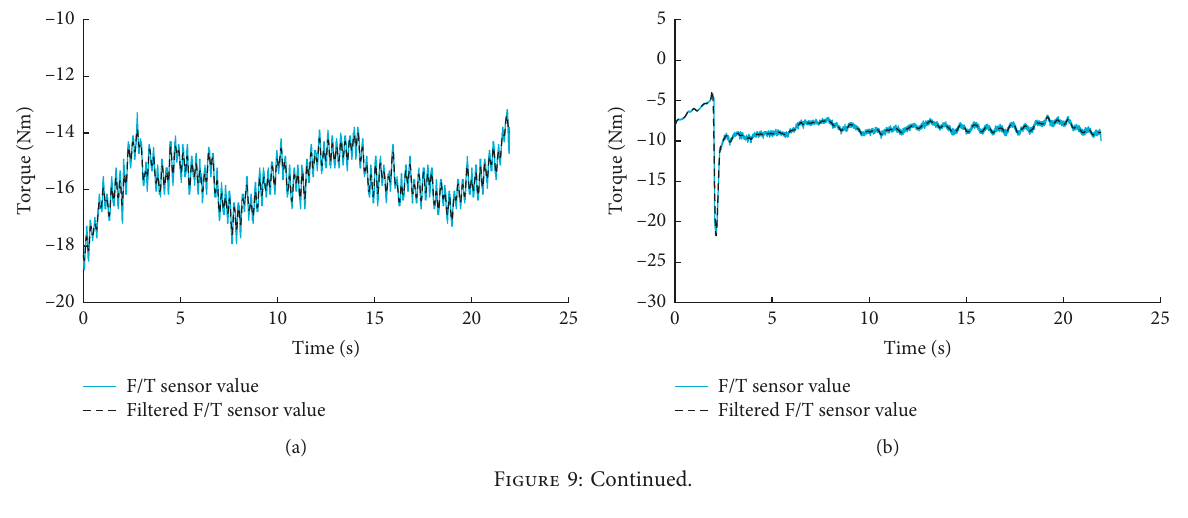
F/T sensor value Filtered F/T sensor